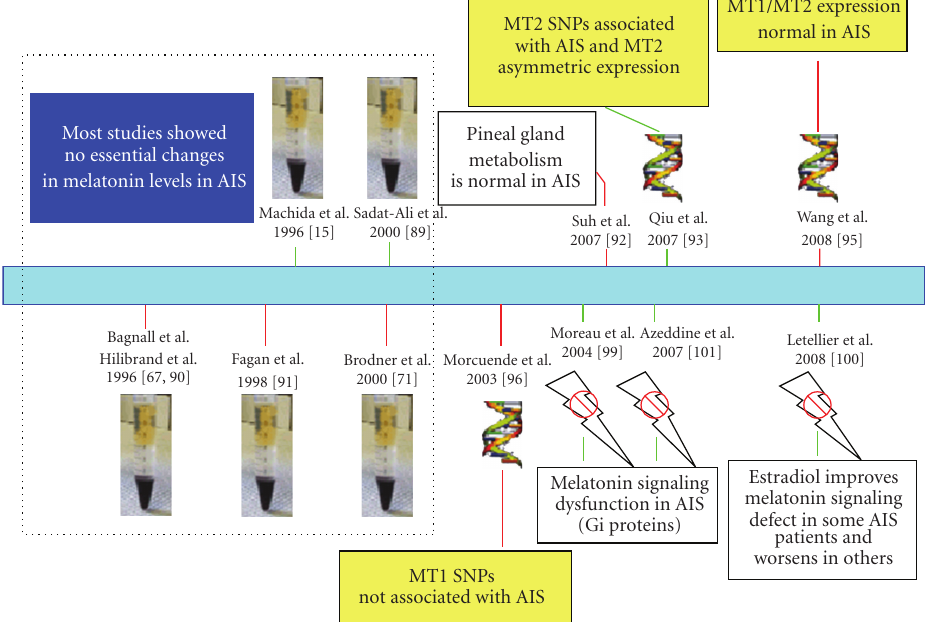
Figure 3: Summary of the main experimental approaches carried out in humans to clarify the role of melatonin on the AIS. Left, (doted rectangle), studies of changes in melatonin production. Yellow labels are the screening of polymorphisms in genes related with pineal function. White labels identify studies of possible changes in melatonin metabolism or response of target tissues. As in Figure 2, e ff ective (green lines) and none ff ective (red lines) results are indicated. Modified from Moreau et al.